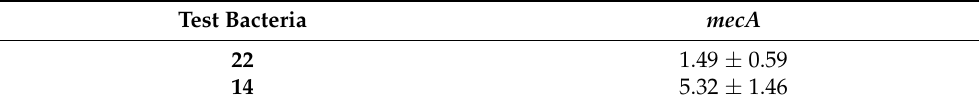
Table 4. Relative fold change in mecA gene expression levels of test bacteria 14 and 22 , which developed resistance to oxacillin after 30 days of exposure to aluminum chlorohydrate, and the control group test bacteria taken on the first day as the